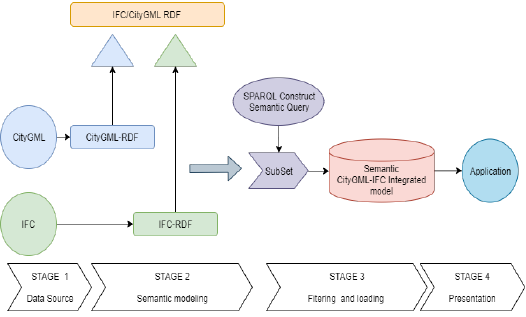
Figure 2: BIM-GIS integration data workflow diagram The transformation of the CityGML data to the RDF model is completed through a direct mapping to a designated class in the ontology tar- get model; every element is mapped to one class.